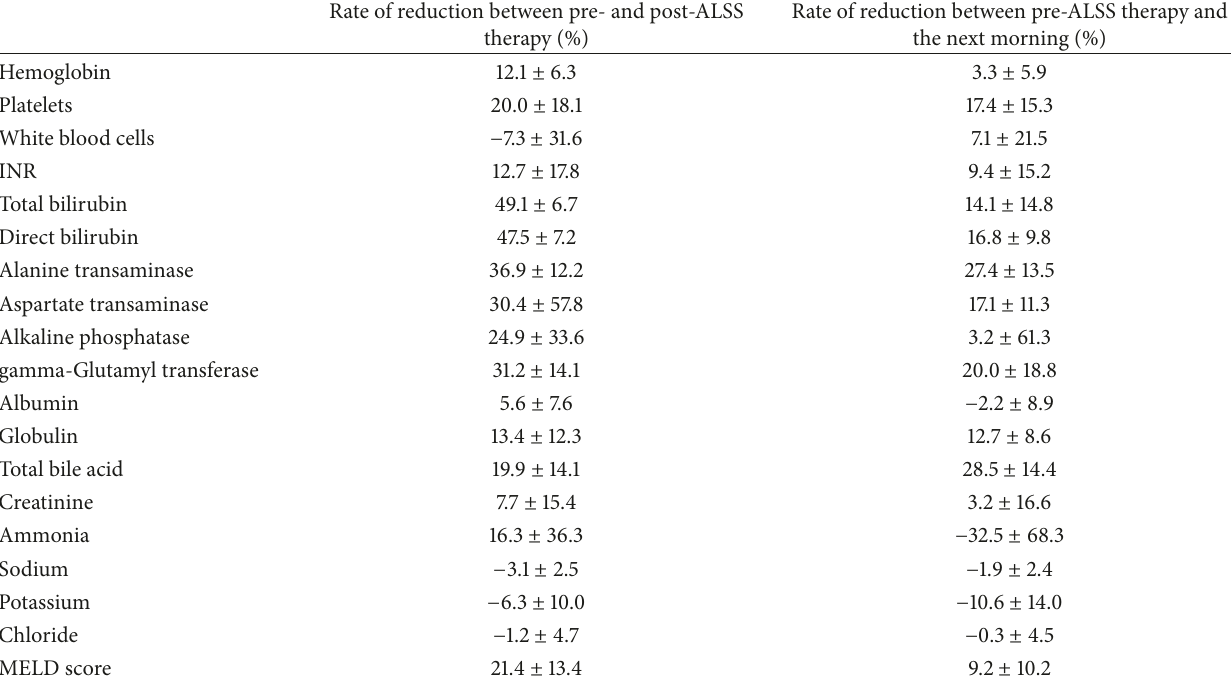
Table 2: Immediate effect of the first session of ALSS therapy.